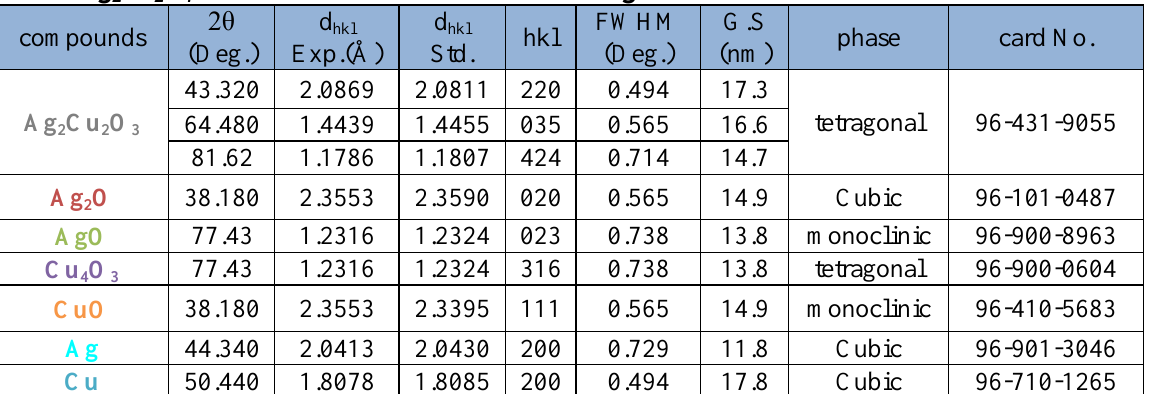
Table 5: Structural parameters viz. inter-planar spacing, crystallite size and Miller indices of Ag Cu O films sintered at 200 °C and annealing at 200 °C for half an hour. 2 2 4 2θ compounds (Deg.)